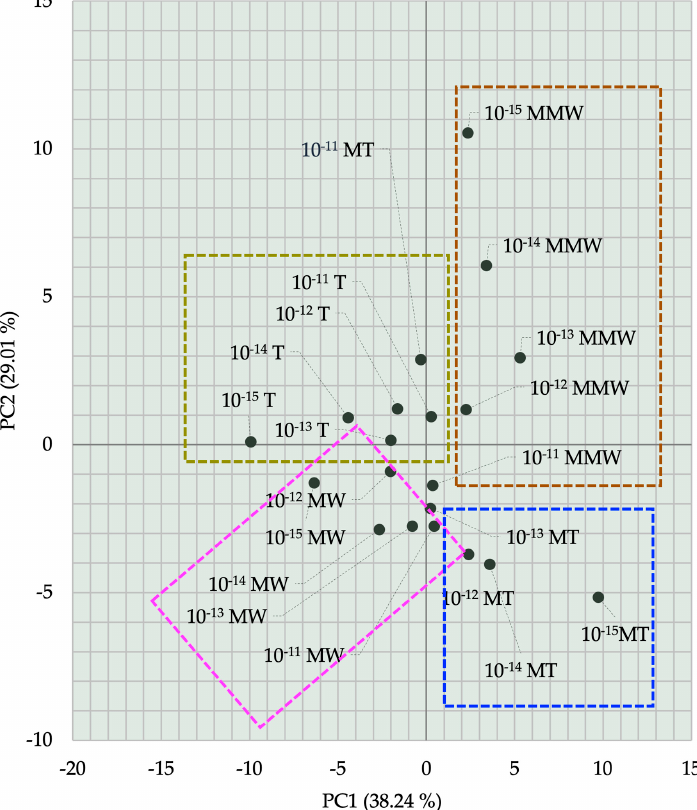
Figure 3. Principal components analysis (PCA) plot of TCS concentrations (from 10 − 15 to 10 − 5 M) distinguished with an electronic tongue sensor, composed by MWCNT5, MWCNT10, MWCNT10-85 and TiO 2 sensors, immersed in T, MW, MT and